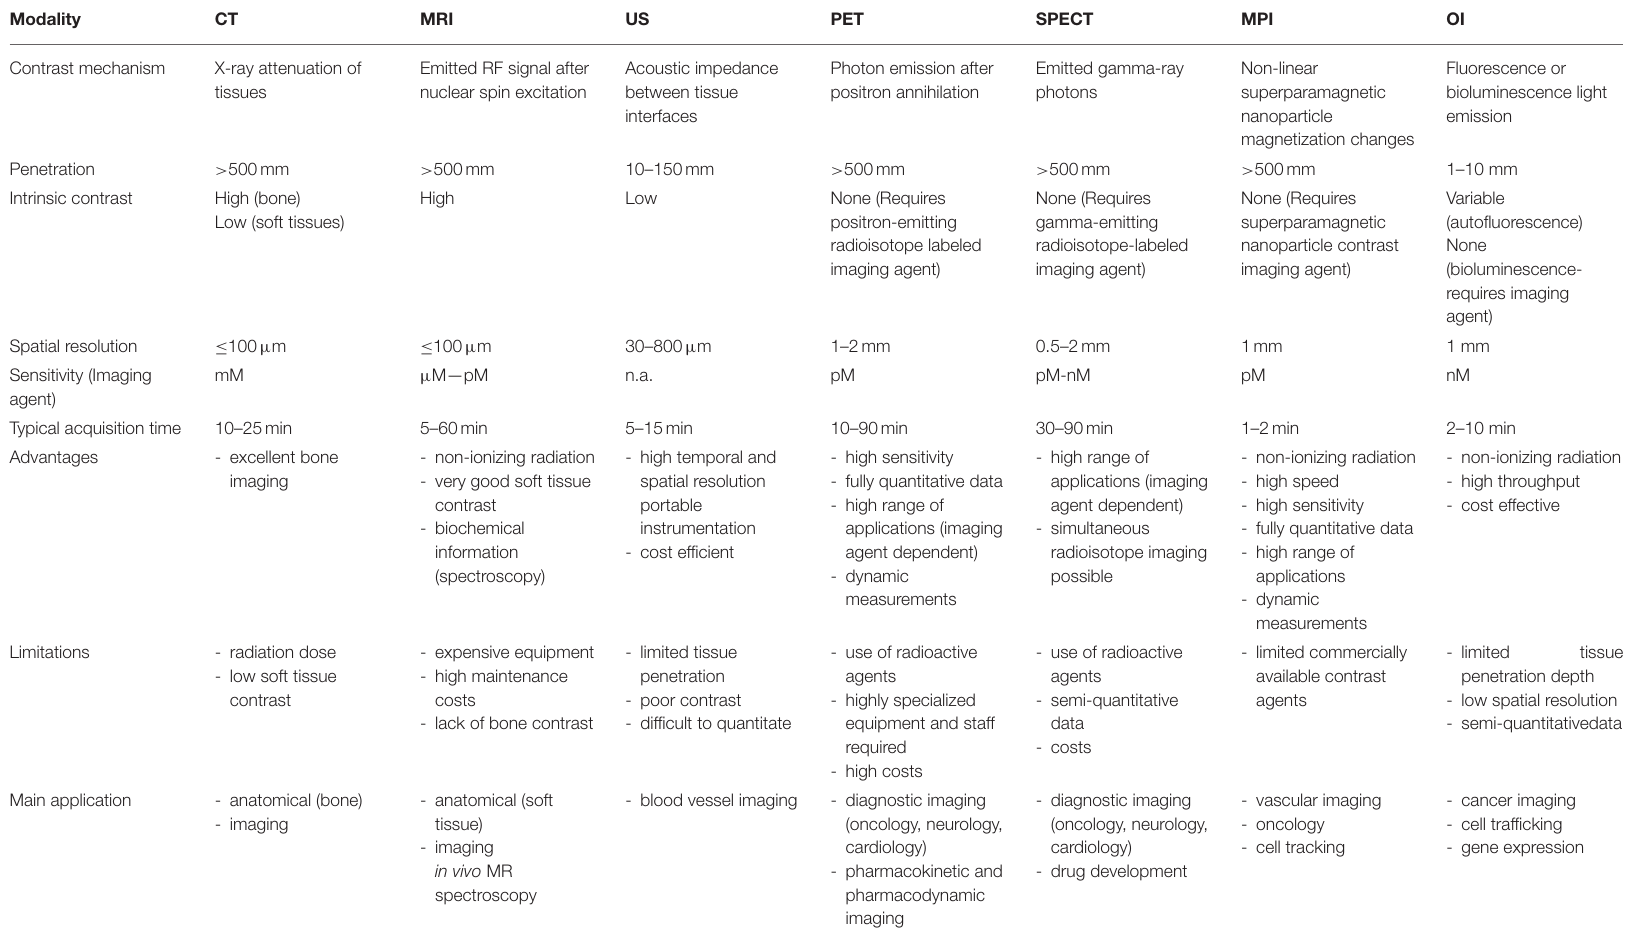
TABLE 1 | Imaging parameters, advantages and limitations of the most used in-vivo preclinical imaging techniques.